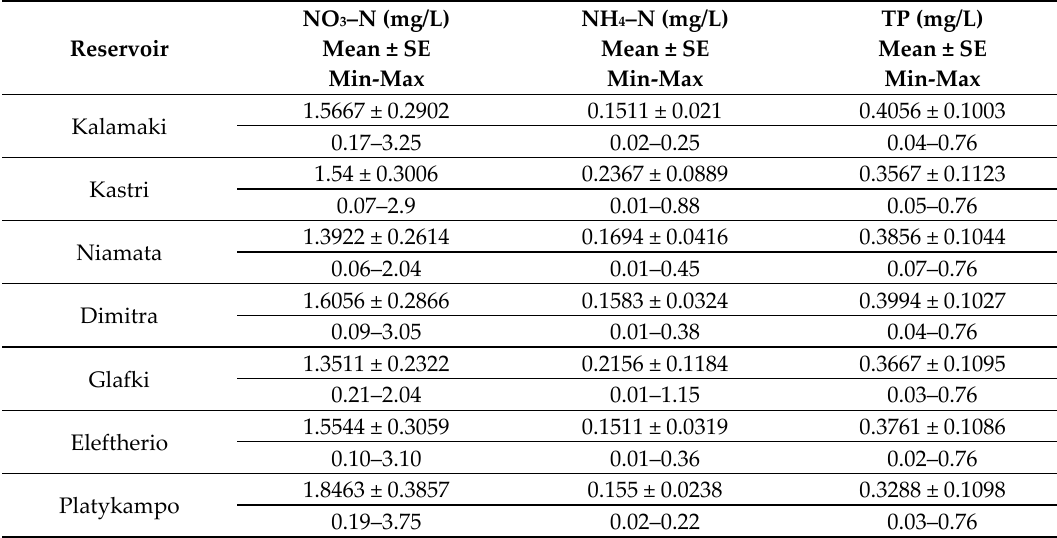
Table 1. Descriptive statistics of nutrient concentrations for each reservoir during the sampling period 2014–2016. SE: standard error, min: minimum, Max: